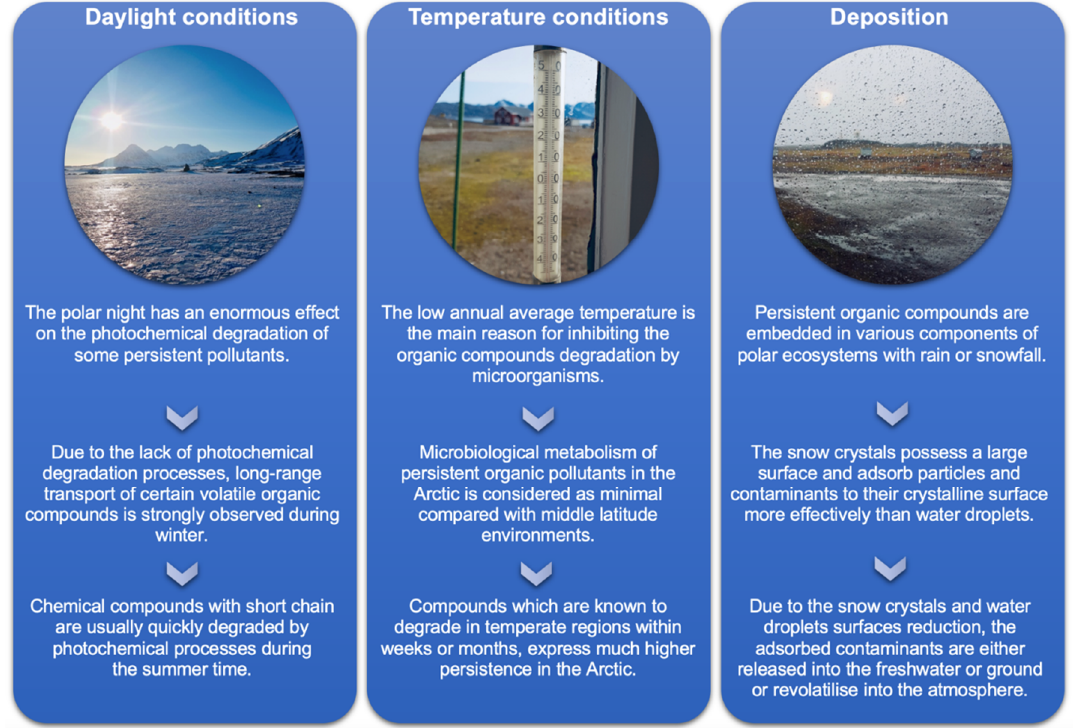
Figure 1. Parameters favouring the potential accumulation of pollutants in the Arctic [20]. All photographs appearing in the article come from the authors’ private archive.